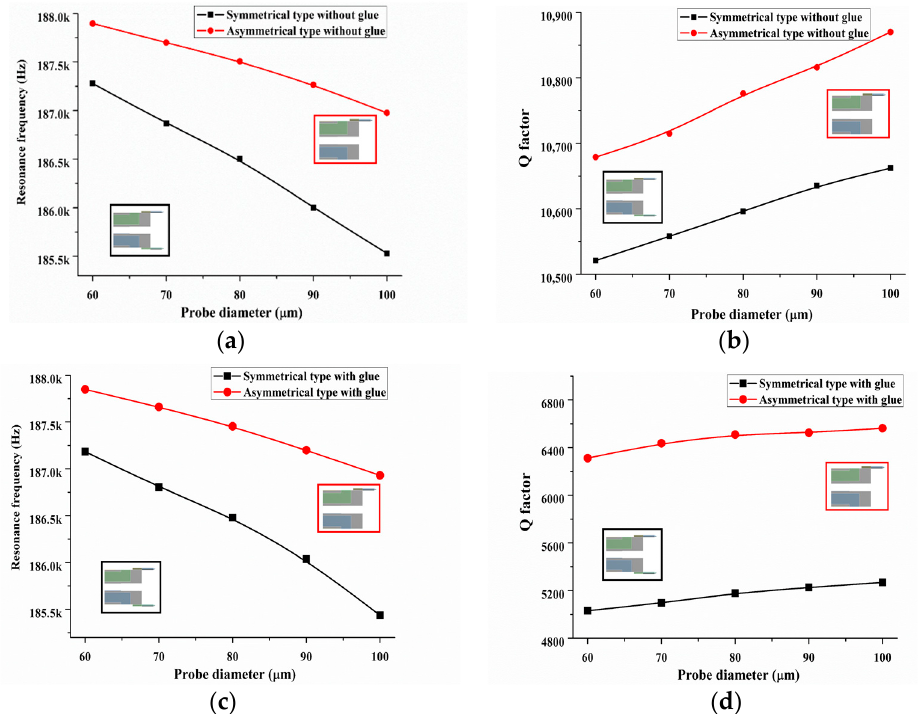
Figure 12. Resonance frequency and Q -factor of QTF-p without glue ( a , b ) and with glue ( c , d ) accompanying the increase of the tungsten probe diameters for two typical probe configurations (asymmetrical and symmetrical).